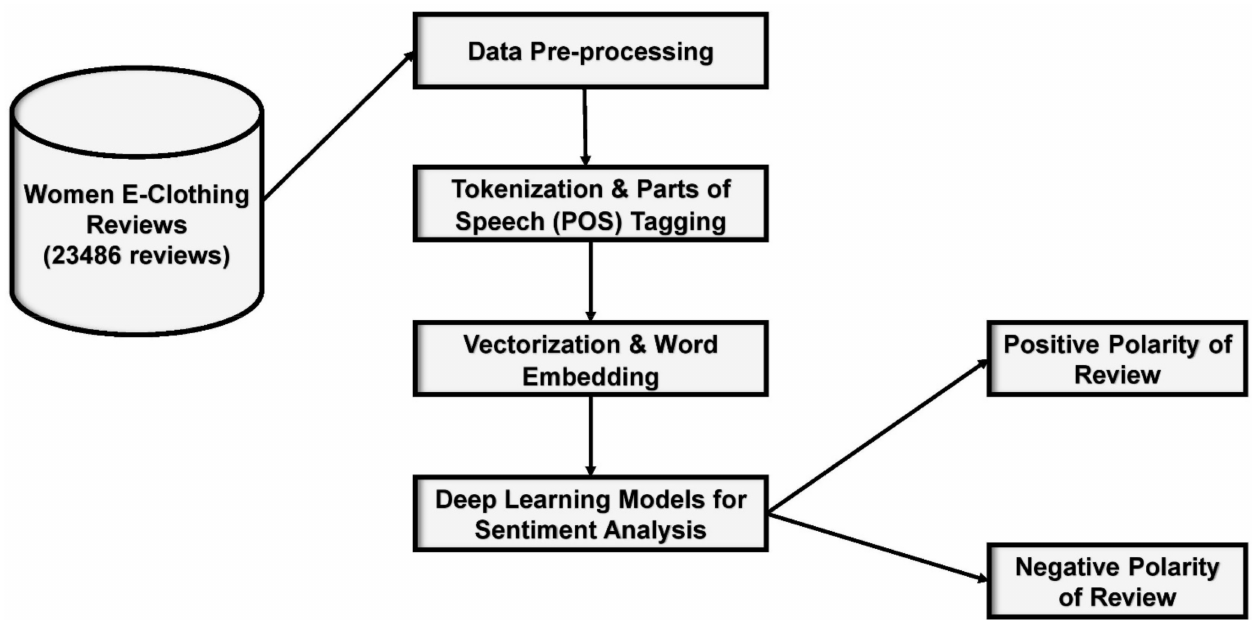
Figure 1. The flow diagram of the proposed